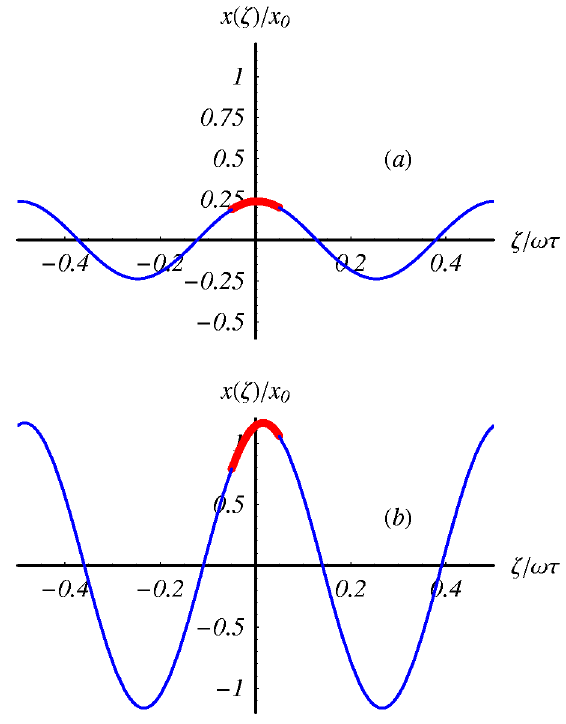
FIG. 2. (Color) Same parameters as in Fig. 1 but with Q (cid:7) 10 4 .FIG. 1. (Color) Steady-state displacement and shape of an